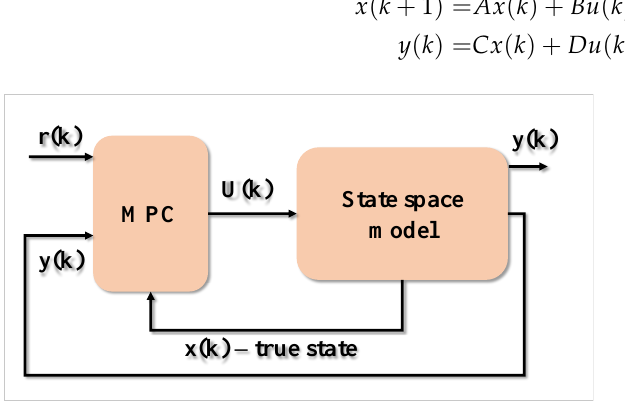
Figure 9. MPC with true state